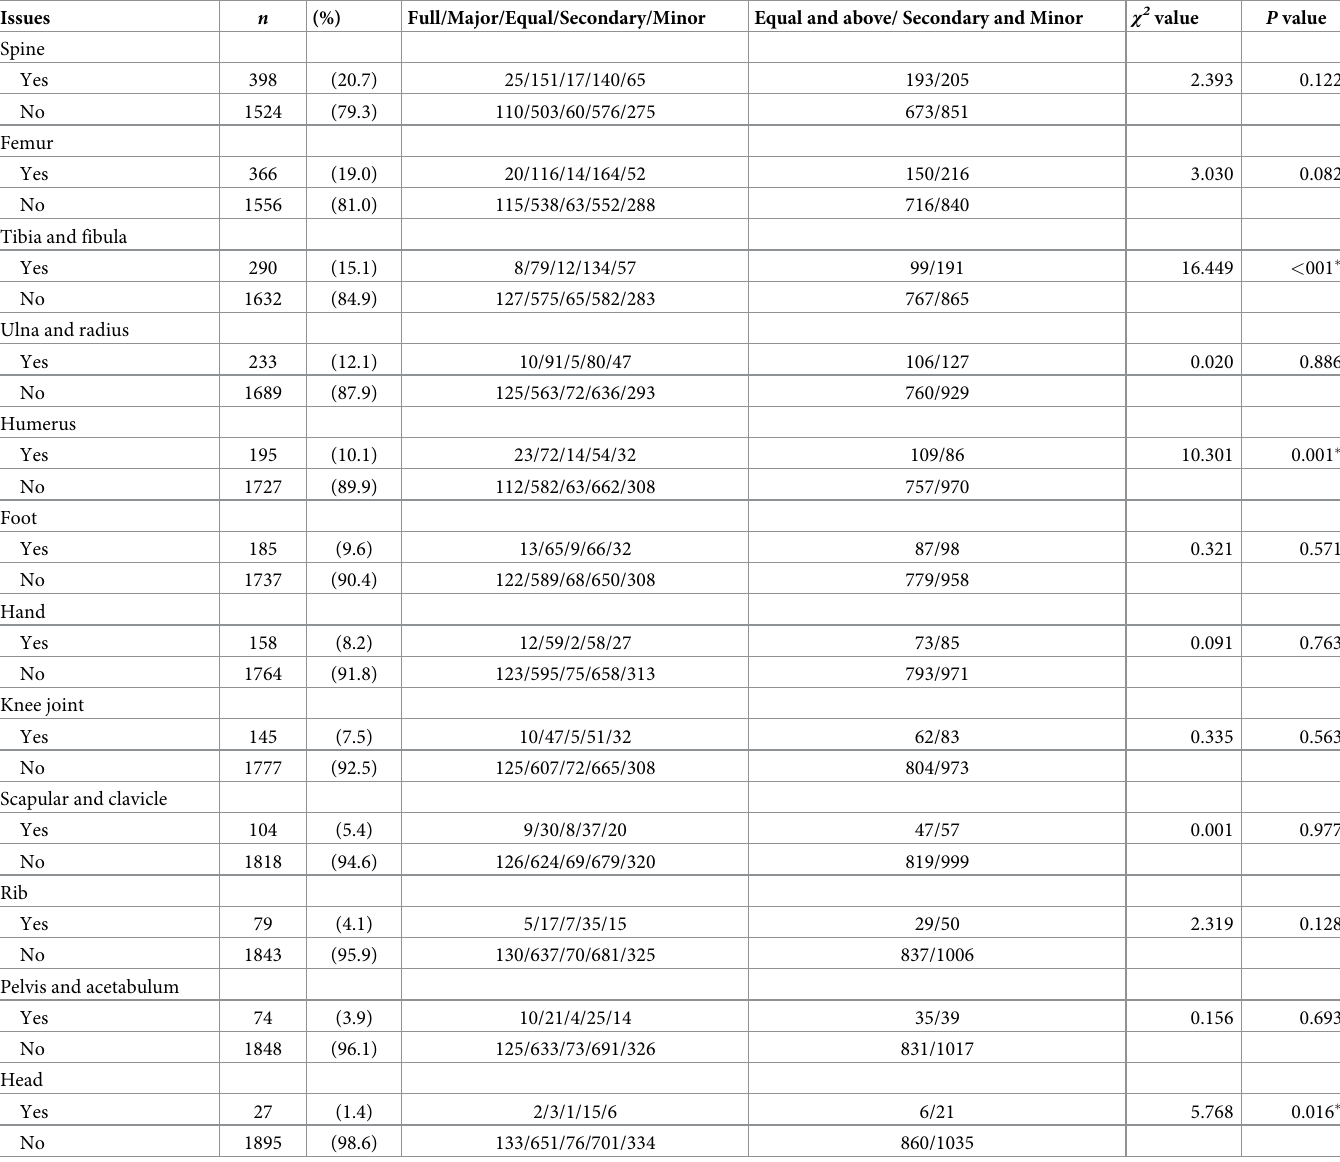
Table 3. Orthopedist’s degree of responsibility for medical malpractice according to injury sites in China between 2016 and